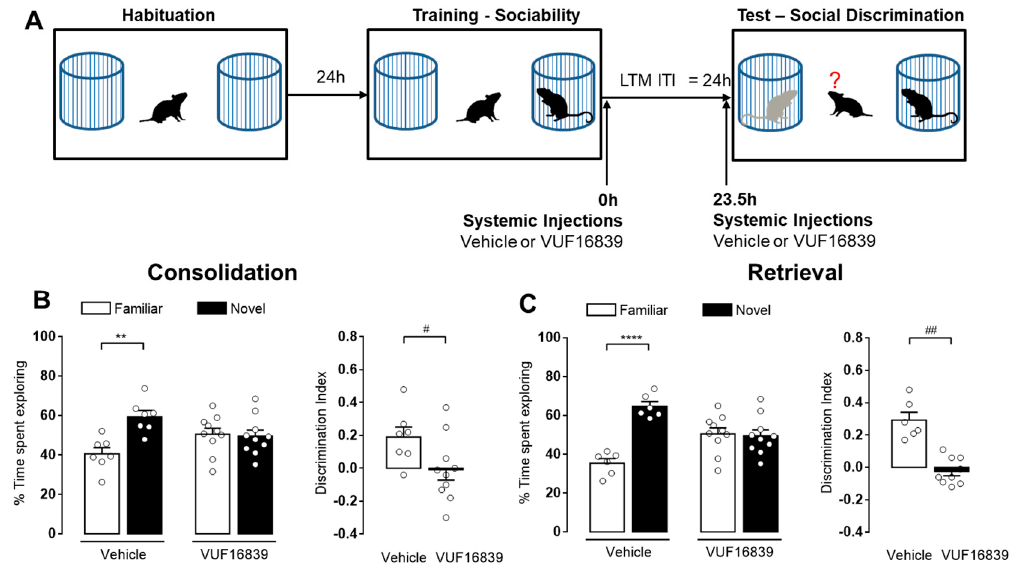
Figure 3. Reduction of histamine release induced by H 3 R activation impairs short- and long-term social recognition memory. ( A ) Schematic drawing showing the sequence of the behavioral procedures. VUF16839 (5 mg/kg, i.p.) or vehicle were injected to Hdc +/+ male mice 0.5 h before the training session. Retention tests were performed 1 h ( B ) or 24 h ( C ) after training. Shown are means ± S.E.M. of 7–10 animals per experimental group. **** p < 0.0001, ** p < 0.01 by two-way ANOVA and Bonferroni’s MCT; # p < 0.05 by unpaired t -test.